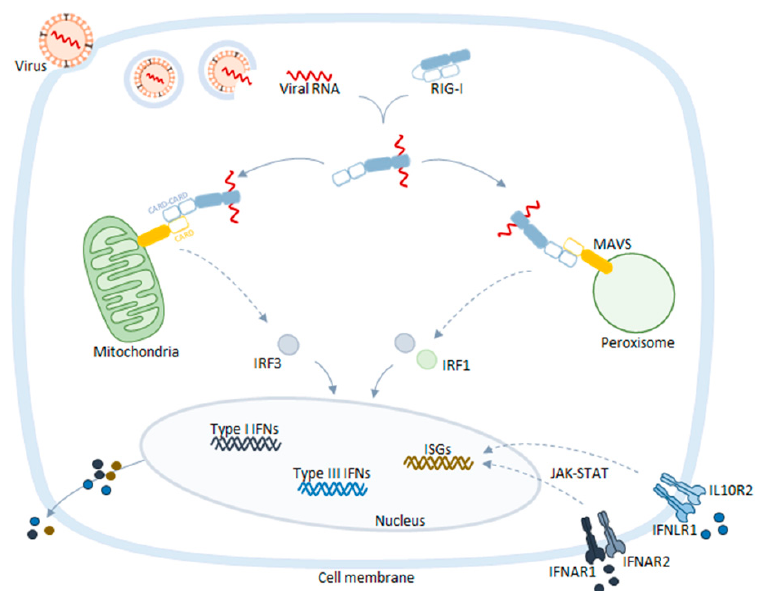
Figure 1. Mitochondrial antiviral signaling protein (MAVS)-dependent antiviral signaling